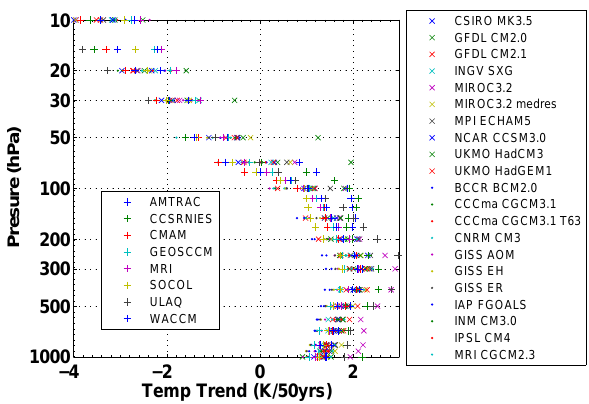
Fig. 1. Global and annual mean temperature trends for AR4 and CCMVal-1 models. Dots: AR4 models without ozone recov- ery, crosses: AR4 models with ozone recovery, and right-crosses: CCMVal-1